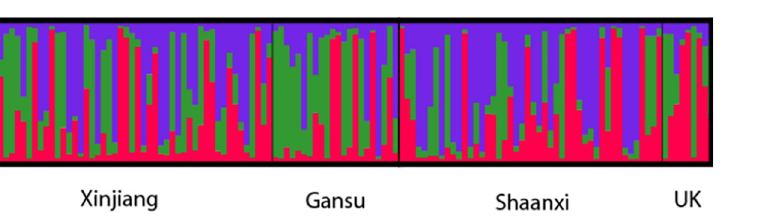
Fig 4. Analysis of Venturia inaequalis population structure shown by bar charts. Population structure showing the ancestry coefficients of Venturia inaequalis in Shaanxi, Gansu and Xinjiang, China, and the U.K. in the form of a bar plot (K = 3). Notes: Each vertical line represents an individual multilocus genotype. Each color represents the most likely ancestry of the cluster from which the genotype or partial genotype was derived. Individuals with multiple colors have admixed genotypes from multiple